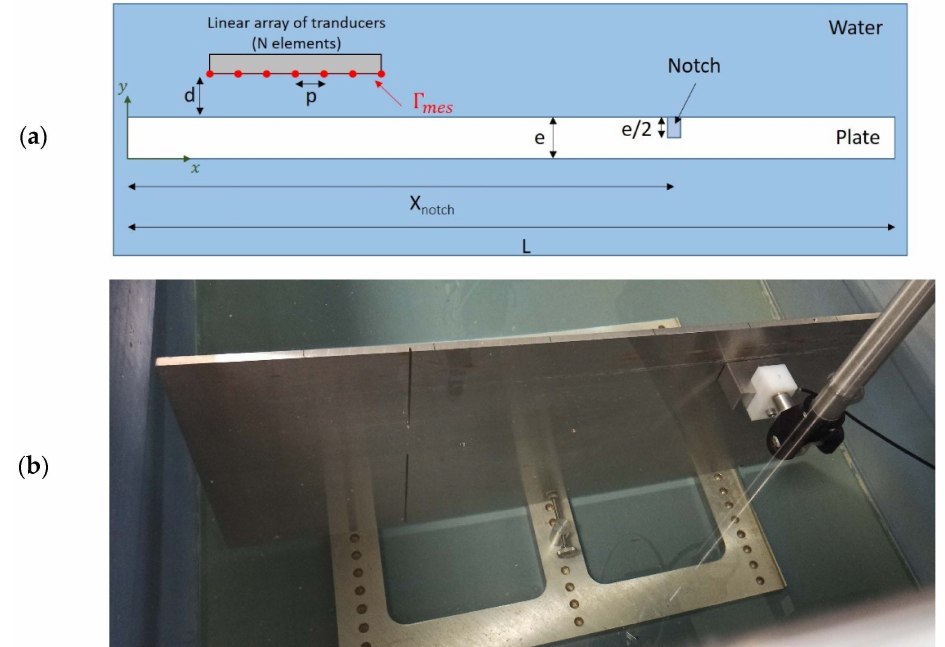
Figure 6. ( a ) Geometry of the experimental setup; ( b ) Experimental